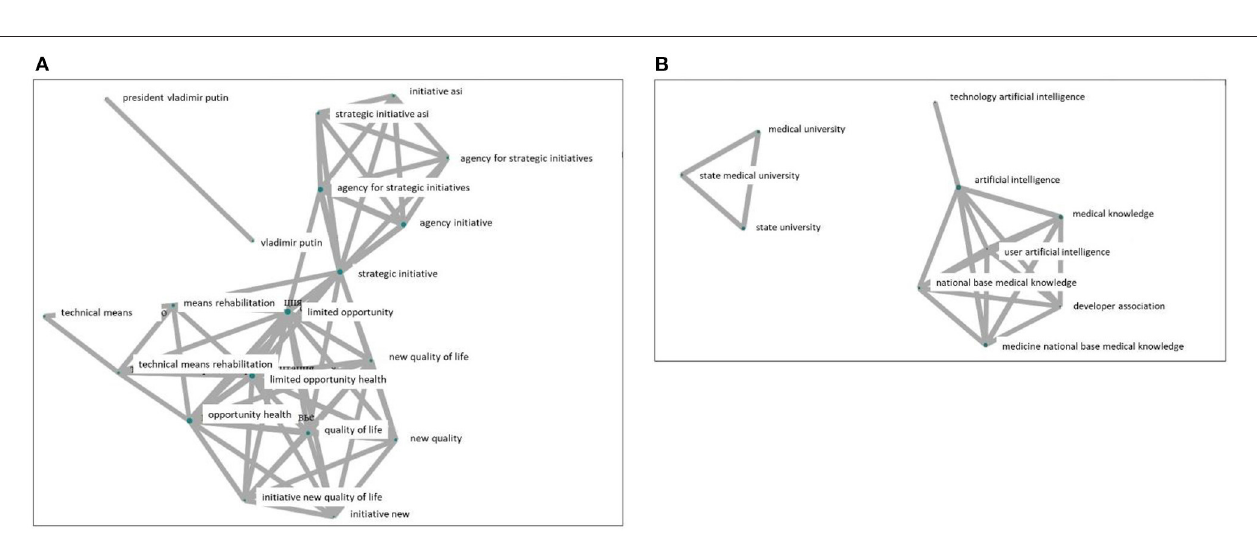
FIGURE 1 | Terms with the highest frequencies of LDA-produced clusters for ASI news online (A) and on Facebook (B) , 2011–2014.